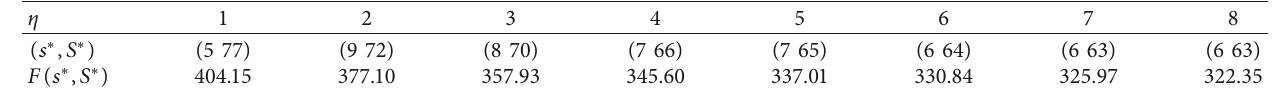
Table 2: The effect of the parameter η on the optimal policy and the optimal cost.